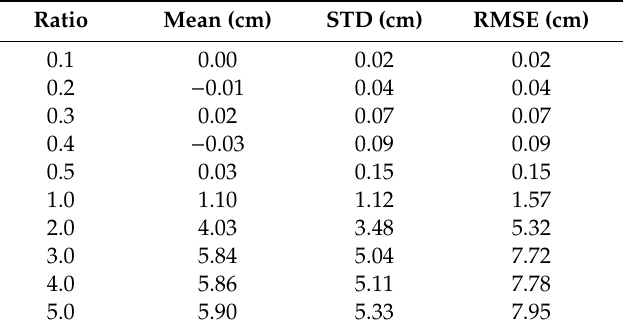
Table 2. Mean, STD and RMS of the proposed method-based subsidence estimation errors under di ff erent ratios of mesh size to deviation of inflection